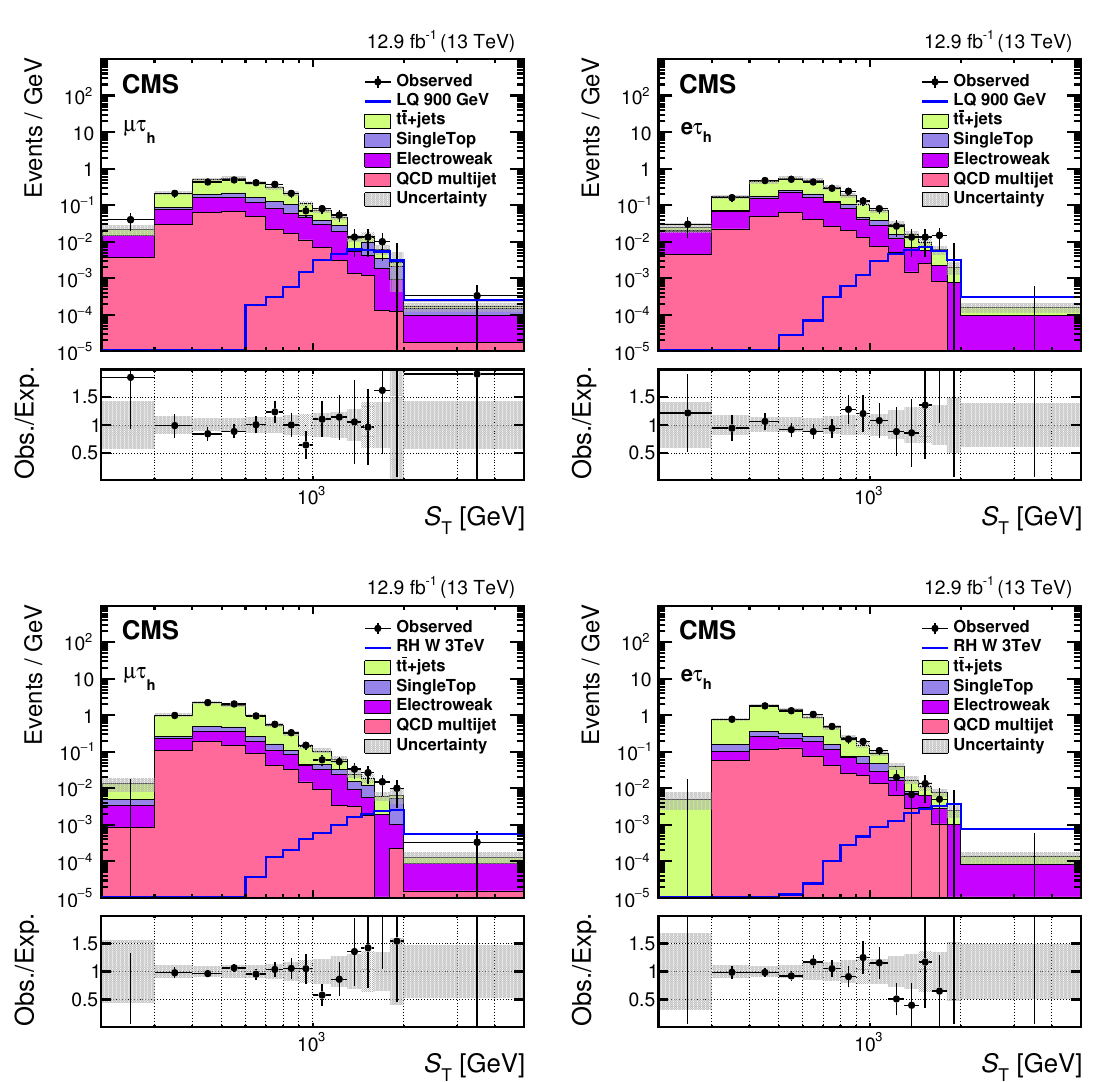
Figure 1 . Measured S T distribution in the (cid:22)(cid:28) h (left) and e (cid:28) h (right) channels of the LQ (upper) and heavy RH neutrino (lower) analyses, compared to the expected SM background contribution. A hypothetical LQ signal of mass M LQ = 900 GeV and a hypothetical heavy W R signal of mass M W = 3 TeV are overlaid to illustrate the sensitivity. The electroweak background represents the R sum of W boson, Z boson, and diboson production. The last bin of each plot contains over(cid:13)ow events. A binned maximum likelihood (cid:12)t is performed on the S T distribution. The uncertainty bands represent the sum in quadrature of statistical and systematic uncertainties, obtained from the (cid:12)t. The lower panels in all plots compare the observed and expected events in each bin.